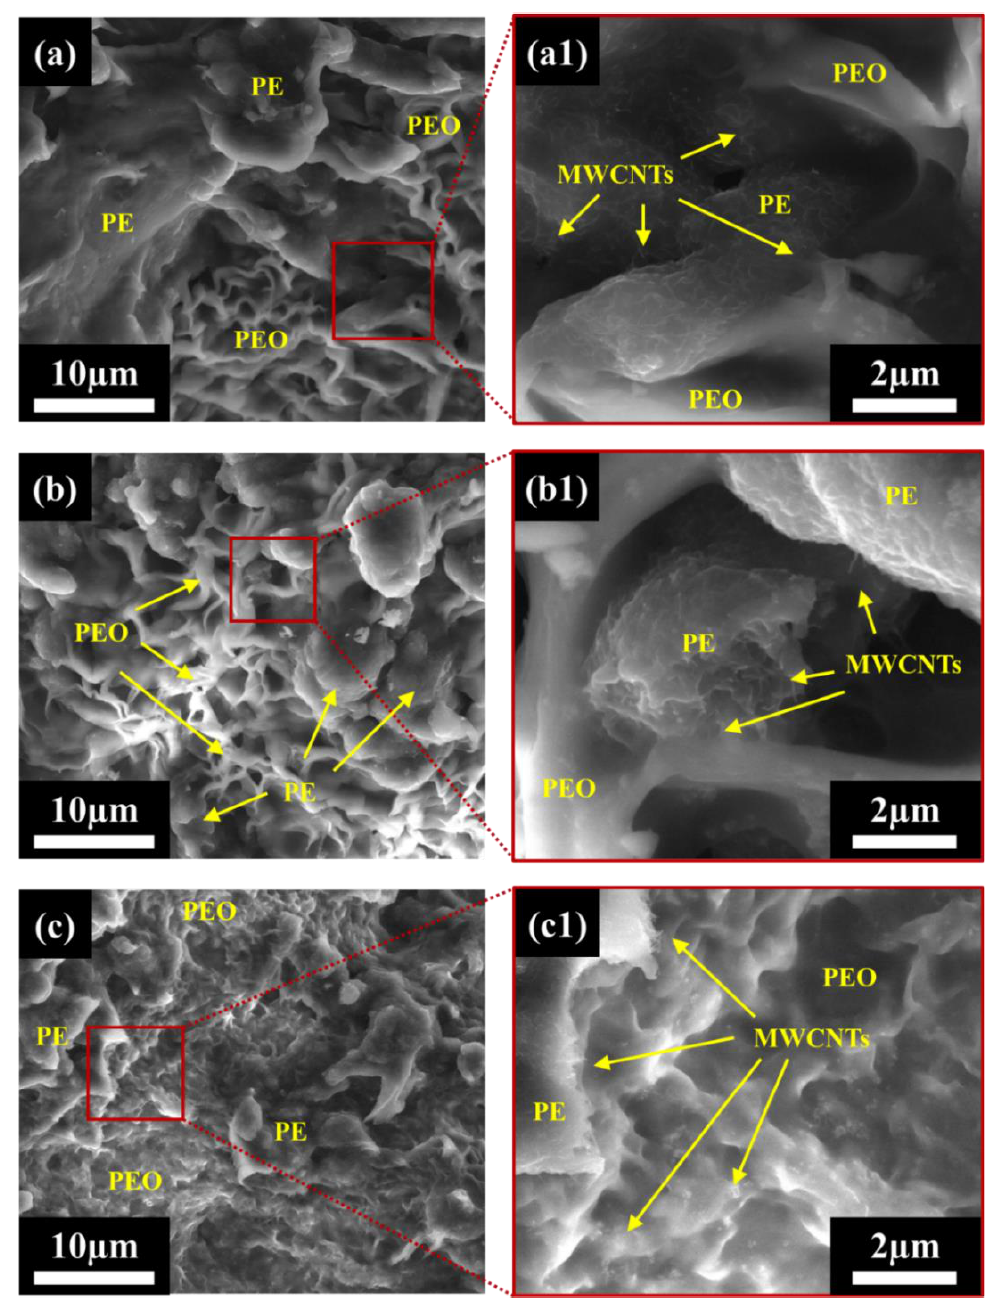
Figure 8. Low field detector (LFD) SEM images of PEO/PE/PEMA 40:54:6 with 3 vol% MWCNTs mixed for ( a ) 1 min, ( b ) 5 min, and ( c ) 10 min. Images ( a1 ), ( b1 ), and ( c1 ) show PEO/PE/PEMA blend morphology at higher magnification.